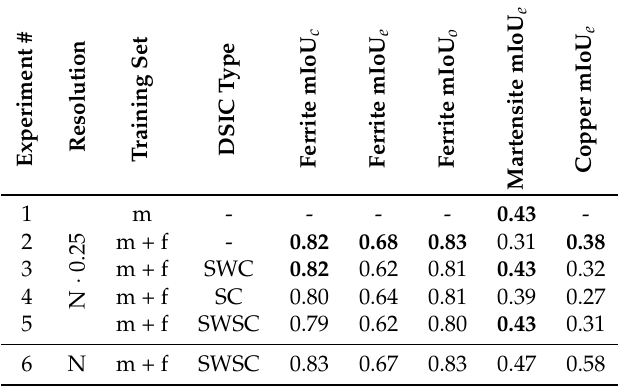
Table 4. Results of different training and testing data sets including data set imbalance correction schemes. The letters m and f in the training set denote martensite and ferrite,